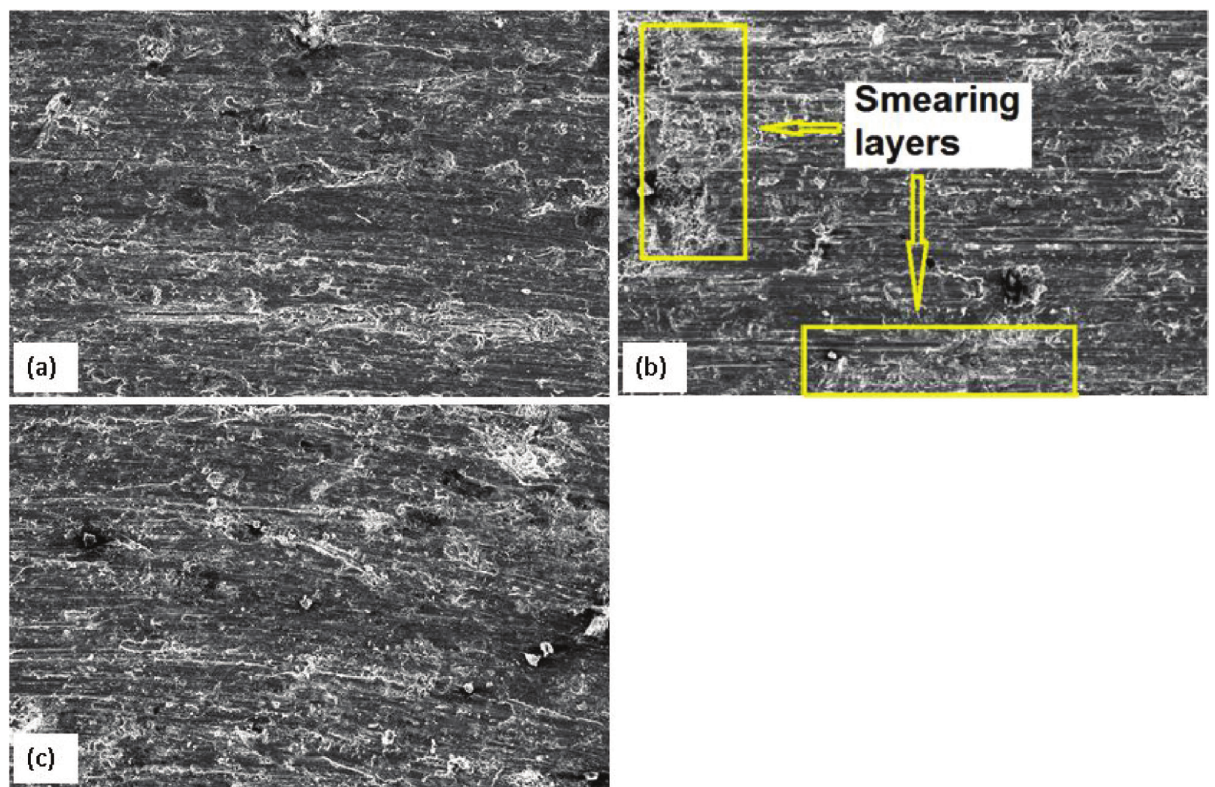
Fig. 12: SEM images of the worn surfaces at 6% R-V ratio composite, manufactured in 4 minutes at 500 rev/min stirring speed and 800 °C liquid matrix temperature, after abrasive wear tests with (a) 10N, (b) 20N and (c) 30N